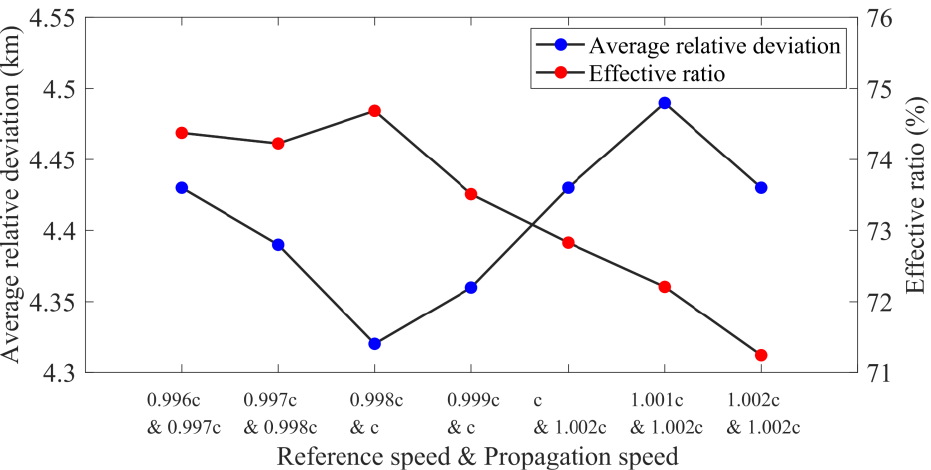
Figure 8. Relative location accuracy metrics for propagation corrected with different reference speeds combined with their best combined propagation speed.